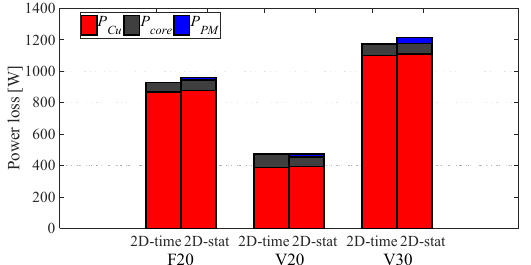
Figure 20. Losses computed using 2D time-dependent FE simulation (2D-time) and the 2D stationary model used for optimization (2D-static) for the chosen geometries.